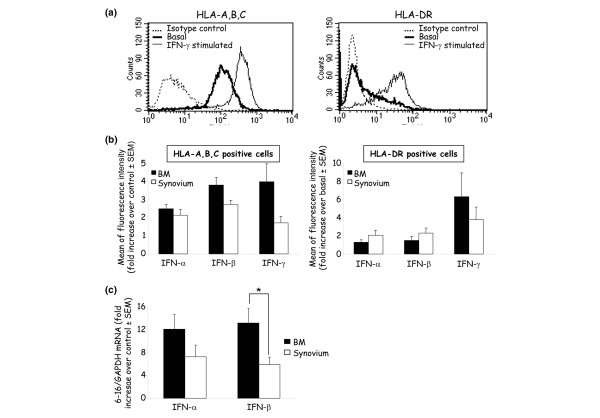
Induction of HLA class I and class II expression by IFN in adherent cells. (a) One example of basal and IFN-γ-induced expression of HLA-A, HLA-B, HLA-C (left) and HLA-DR (right) molecules on mesenchymal stem cells from bone marrow (BM) by fluorescence-activated cell sorting analysis. (b) Expression of HLA-A, HLA-B, HLA-C (left) and HLA-DR (right) molecules by BM-derived cells (n = 5; two normal, two osteoarthritis and one rheumatoid arthritis) and synovium-derived cells (n = 7; three rheumatoid arthritis, two normal, two osteoarthritis) after induction with 1,000 U/ml IFN-α, IFN-β and IFN-γ, shown as the fold increase of the mean fluorescence intensity over the control ± standard error of the mean. (c) Detection of the 6–16 early response gene to IFN, assessed by quantitative RT-PCR, normalized to GAPDH mRNA (n = 3 for synovium-derived and n = 4 for BM-derived cell samples). Results display the fold increase of the 6–16 gene in IFN-induced samples over nontreated samples. * P < 0.05.